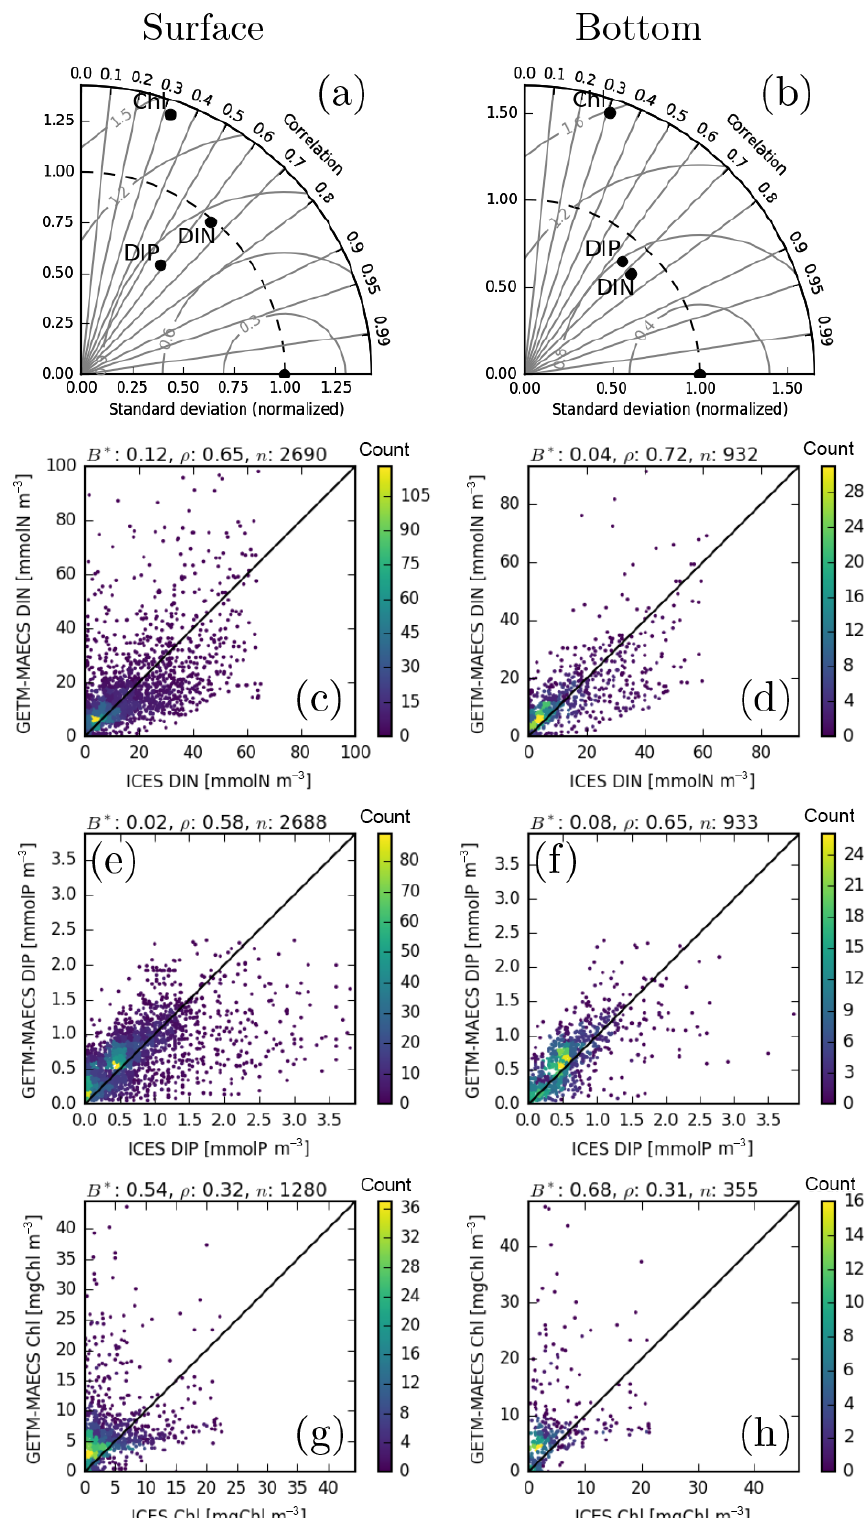
Figure 8. Comparison of simulated and measured (ICES) DIN (a, b, c, d) , DIP (a, b, e, f) and chlorophyll (a, b, g, h) at the surface (left) and bottom (right) layers for the period 2000–2010. The 2-D histograms show the number of occurrences of simulation–measurement pairs. The normalized bias ( B ∗ ), Pearson correlation coefficients ( ρ ) and corresponding number of data points ( n ) are shown on top of the scatter